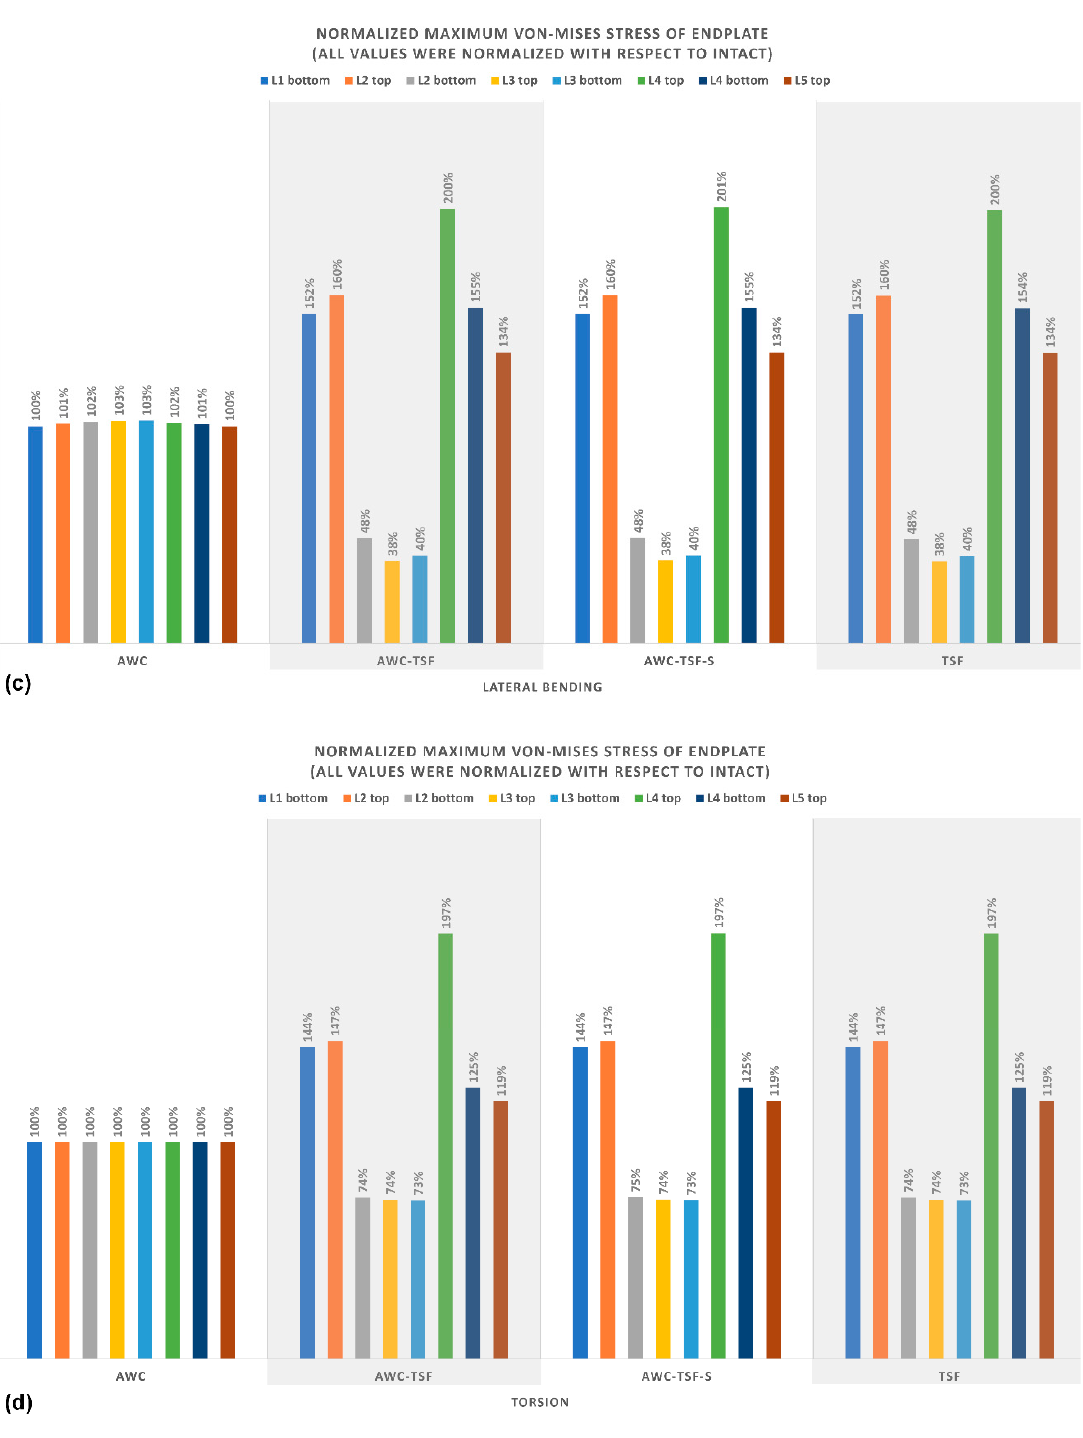
Figure 5. Normalized maximum von Mises stress on the endplate at each level in ( a ) flexion, ( b ) extension, ( c ) lateral bending, and ( d ) torsion in all implanted